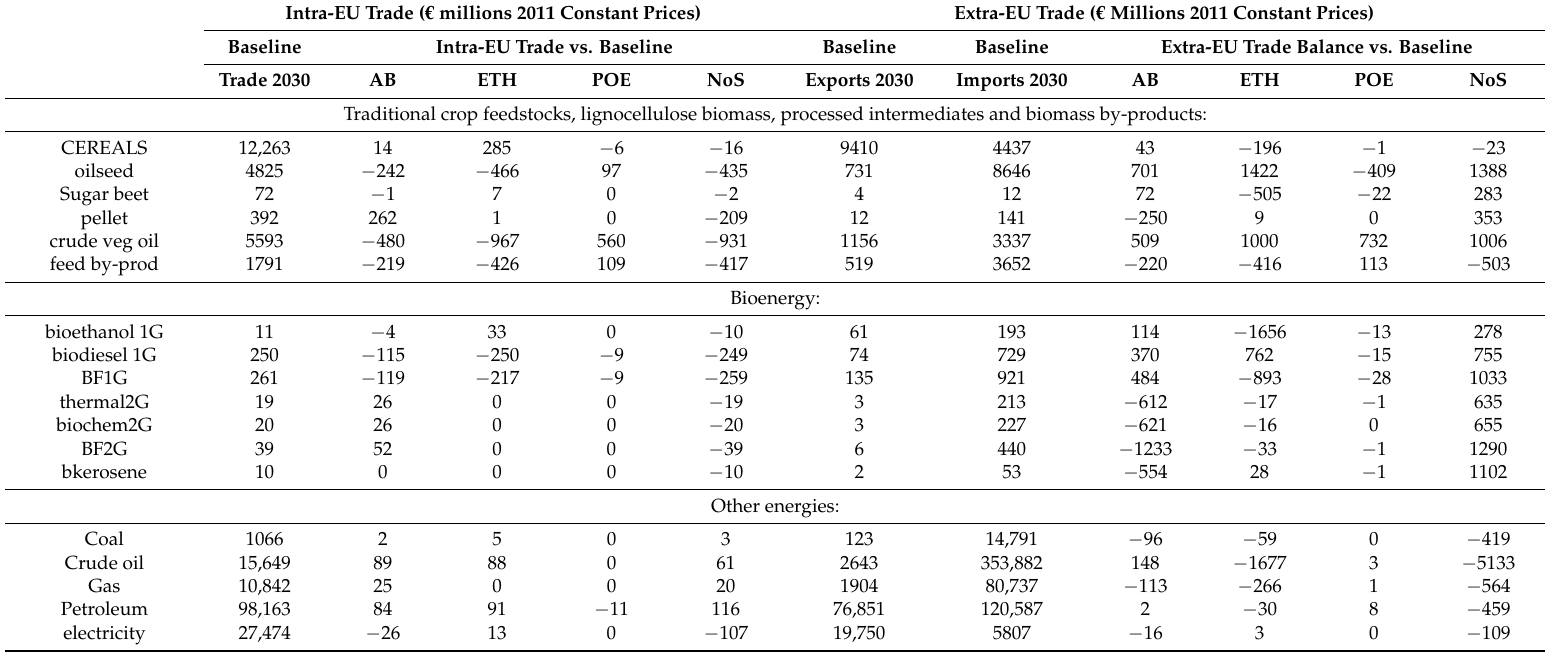
Table 7. EU Trade volumes in constant prices (2011, €